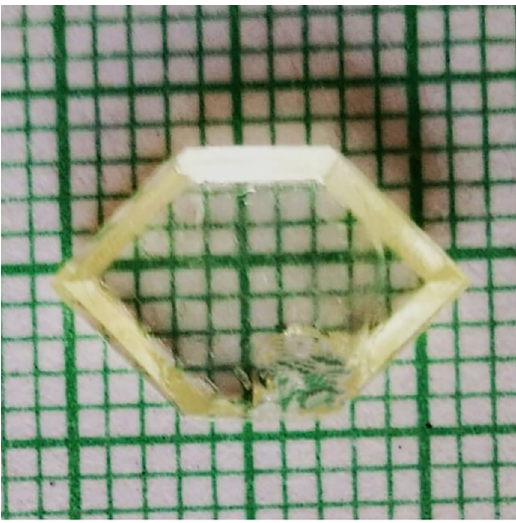
Figure 1. Photograph of GLP crystal.